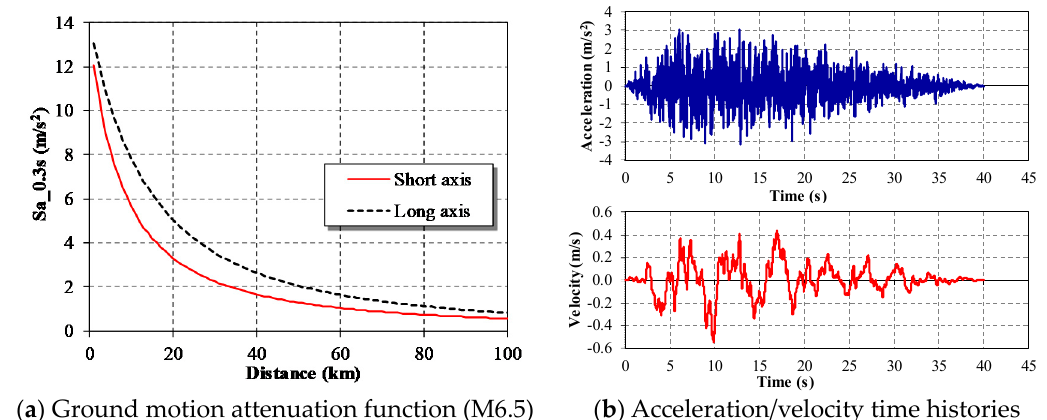
Figure 14. Earthquake data: ( a ) Ground motion attenuation function (M6.5); ( b ) Acceleration/velocity time histories. Appl. Sci. 2020 , 10 , x FOR PEER REVIEW